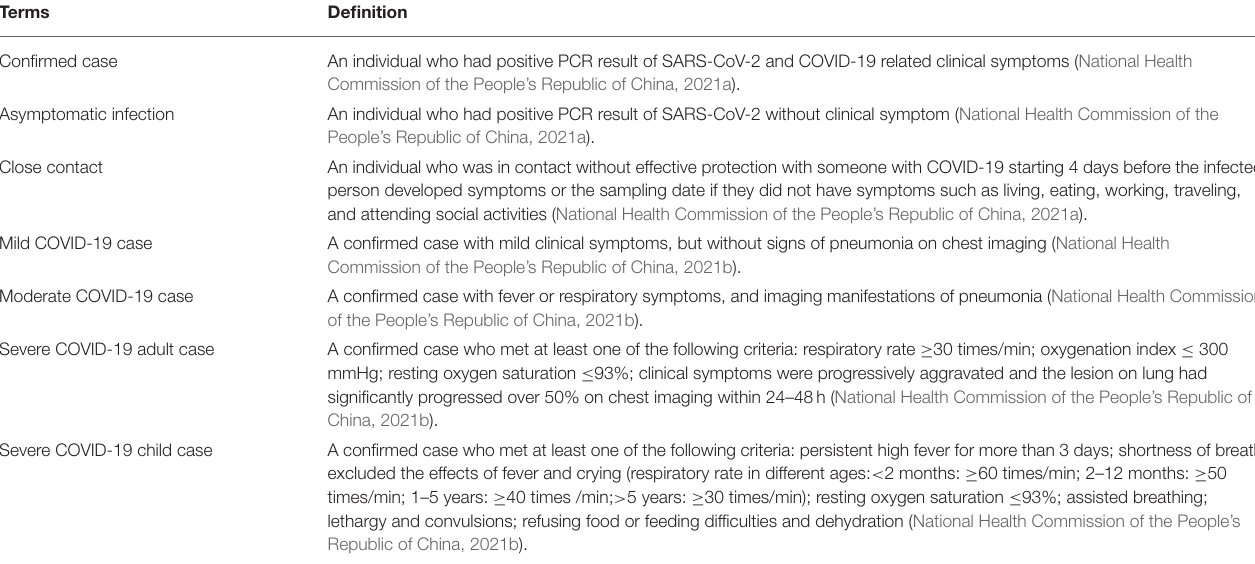
TABLE 1 | Case definition in the SARS-CoV-2 delta variant outbreak in Jingmen City, Hubei Province, China in August